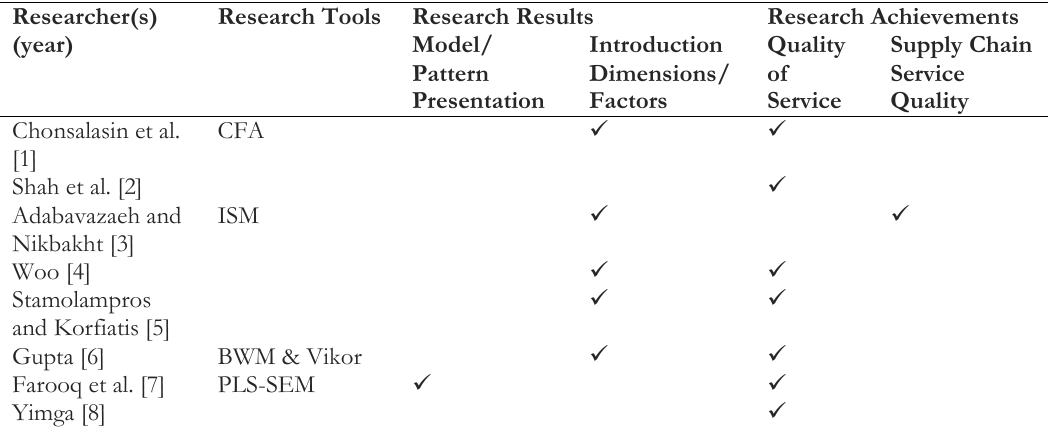
Table 1. Research